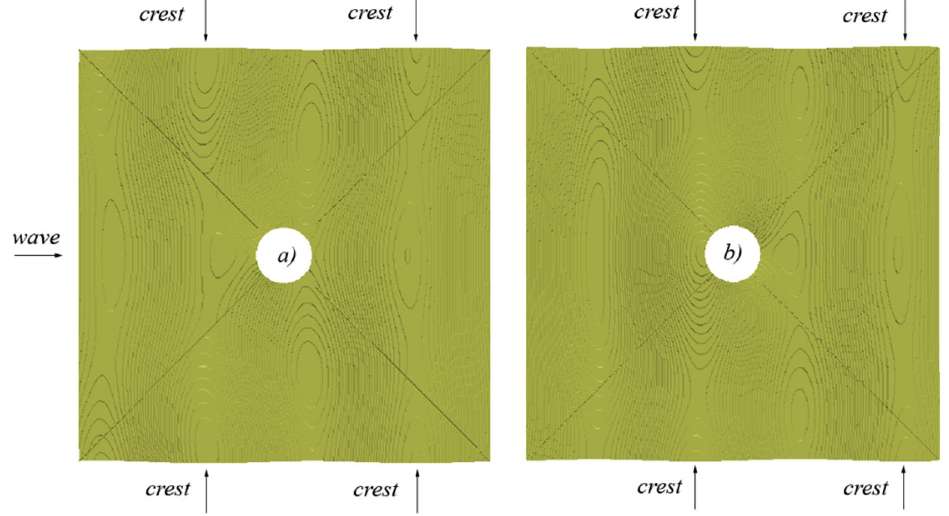
Figure 12. Velocity-potential-derived free-surface profile. Top view of computing domain, at: ( a